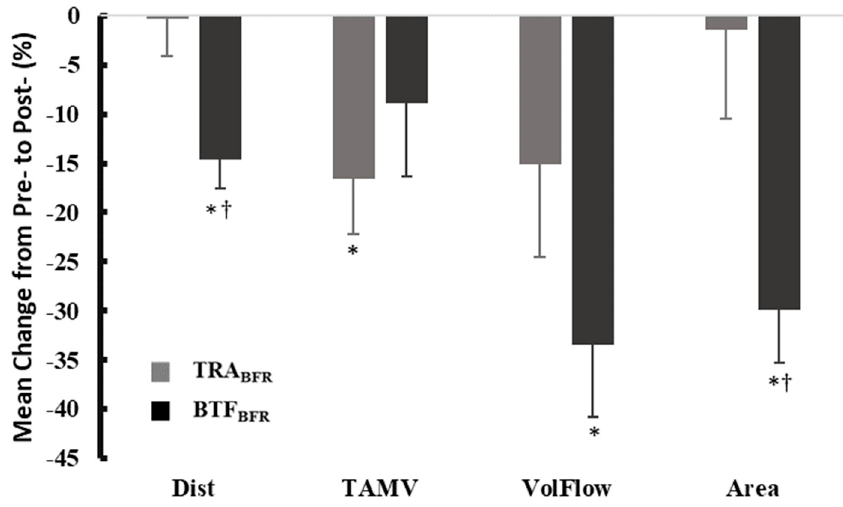
Figure 2. Mean percent change in hemodynamic responses between conditions (M ± SEM). † = Significantly different from TRA BFR ; * = Significant difference in pre-/post-measures within condition. TAMV = Time-averaged mean velocity; VolFlow = volume flow; CON = control; TRA BFR = traditional blood flow restriction; BTF BFR = band tissue flossing. Statistical significance is noted at an alpha level of p < 0.05.